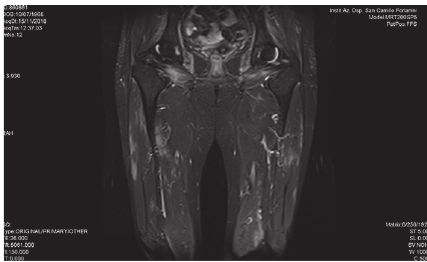
Figure 2: Evidence of diffuse and symmetric muscles oedema of all the muscles of the thigh at